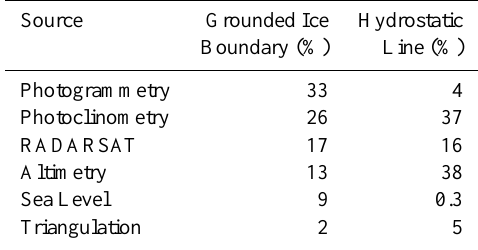
Table 2. Elevation Source for points along grounded ice boundary and hydrostatic line.